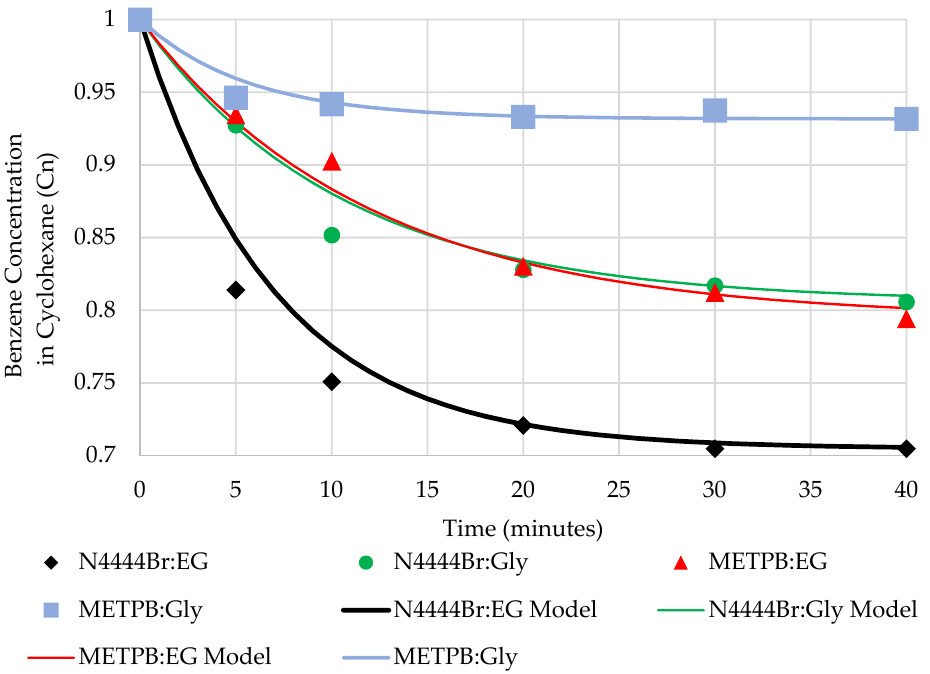
Figure 5. Normalized Benzene Concentration in Cyclohexane; Sample Kinetics for Initial Concentration of 2 Mass% Benzene .